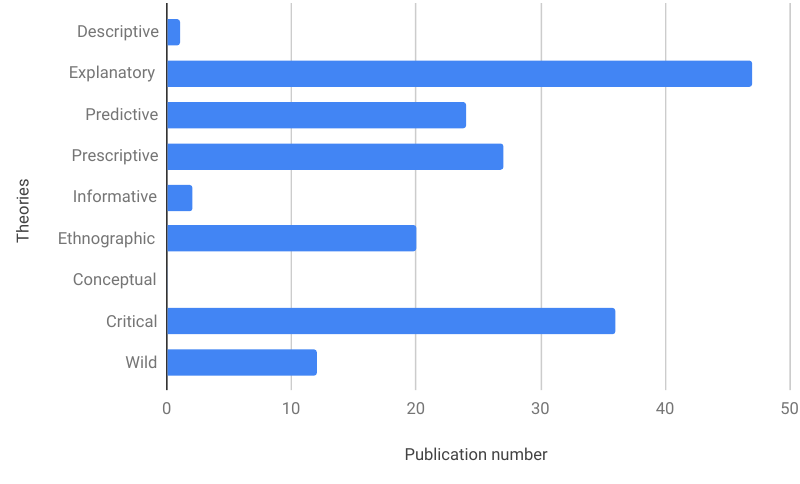
Figure 3. Conceptual framework used in the review